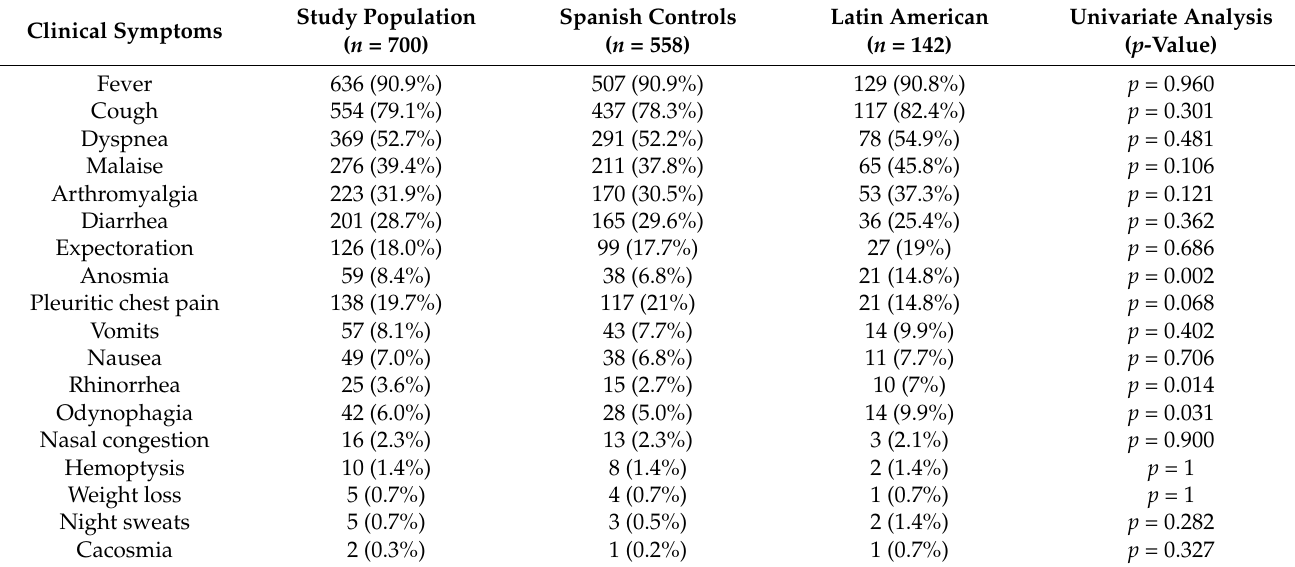
Table 2. Clinical symptoms at admission in hospitalized patients with COVID-19 pneumonia according to the geographical area of origin.